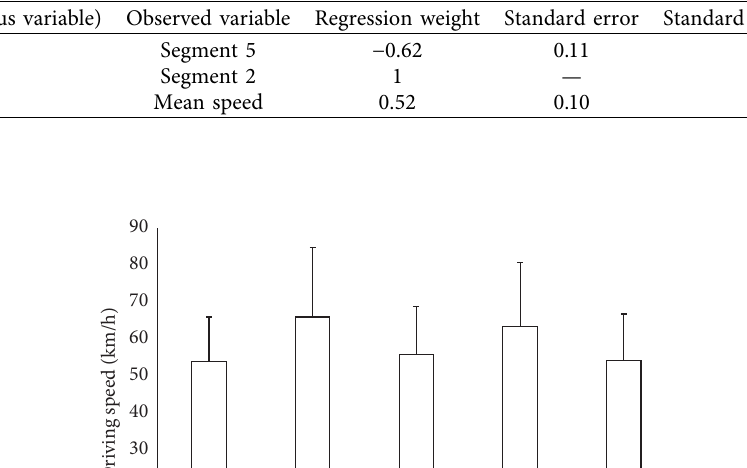
Table 13: SEM results for the latent variable “Geometric Design.”